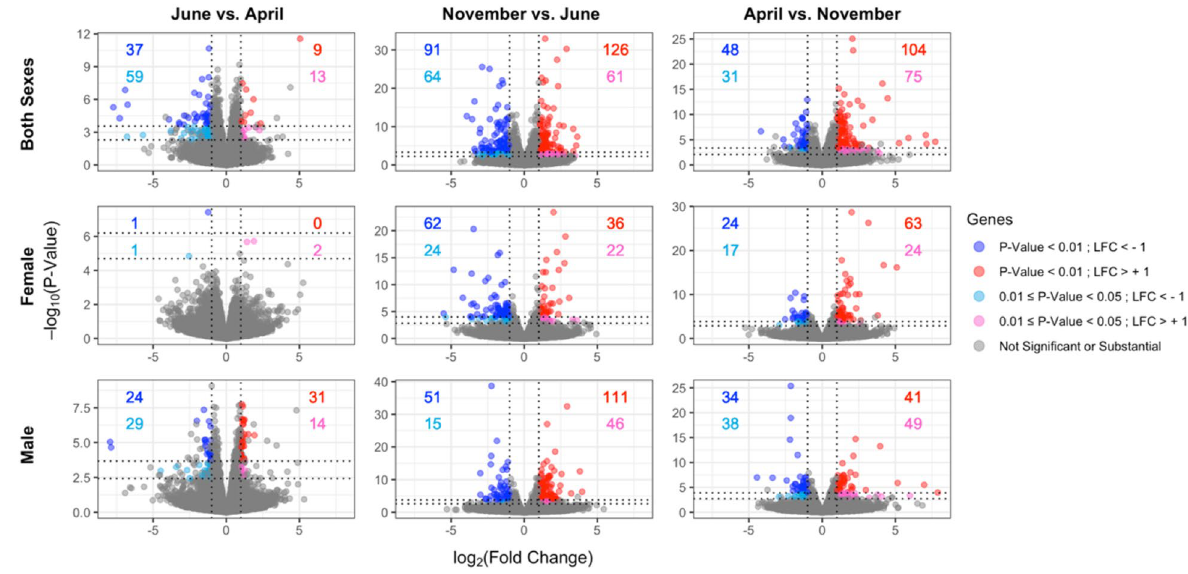
Figure 2. Seasonal differential expression between time points for both sexes, females, and male emus. Volcano plots of month-wise comparisons for each sex condition are displayed. Genes surviving cut offs of − 1 > log 2 (fold change) > 1 correspond to down-regulated genes (dark and light blue) and up-regulated genes (red and pink), and Benjamini–Hochberg corrected p-value < 0.01 (dark blue and red), or Benjamini–Hochberg corrected p-value between 0.01 and 0.05 (light blue and pink) are displayed. The number of genes associated with these classes is coloured for each condition of p-value and log 2 (fold change) (LFC) cutoffs within each comparison. Grey points indicate genes that either did not survive the thresholds and, therefore, were not significant, or those that were deemed non-substantial as determined by DESeq2 21 , as described in the